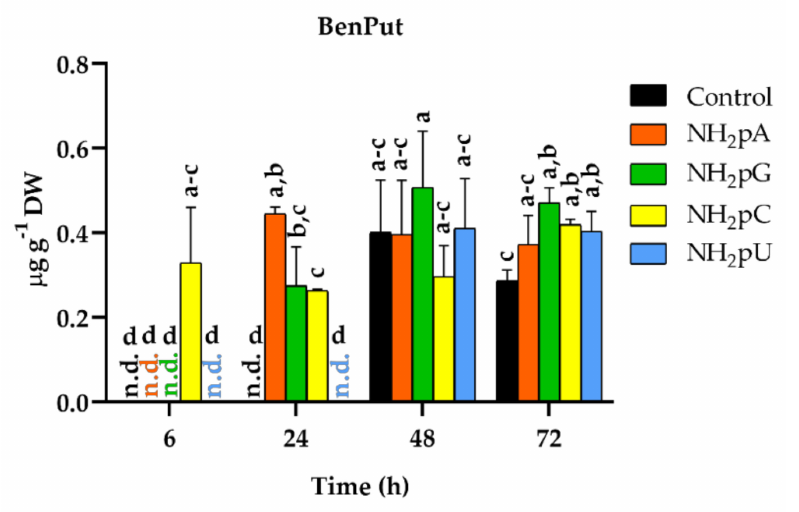
Figure 9. BenPut accumulation in cells of Vitis vinifera treated with 5 µ M nucleoside 5 (cid:48) - phosphoramidates. Values represent the mean ± standard deviation of the three replicates. Values without a common letter were significantly different according to ANOVA and Tukey’s HSD multiple range test ( p ≤ 0.05). n.d., not